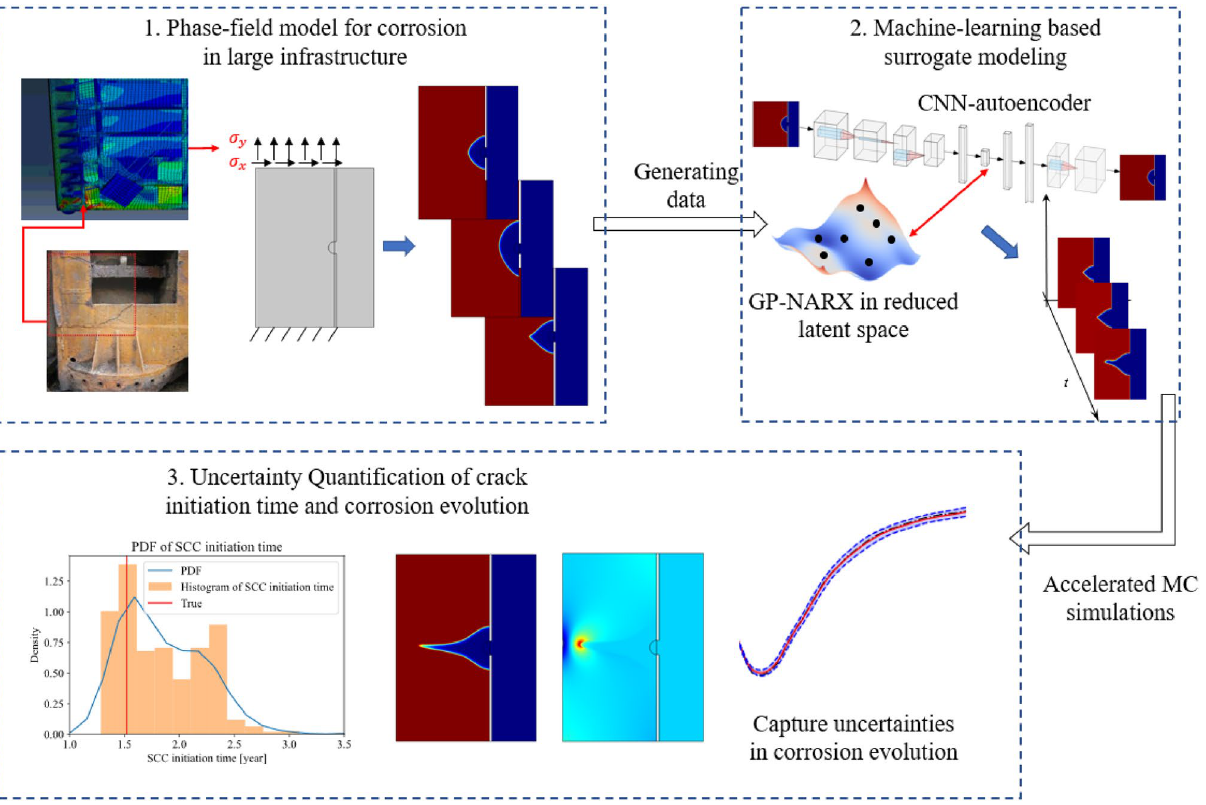
Figure 1. Overview of the proposed surrogate model-accelerated probabilistic analysis framework for corrosion-to-cracking prediction in large structures.